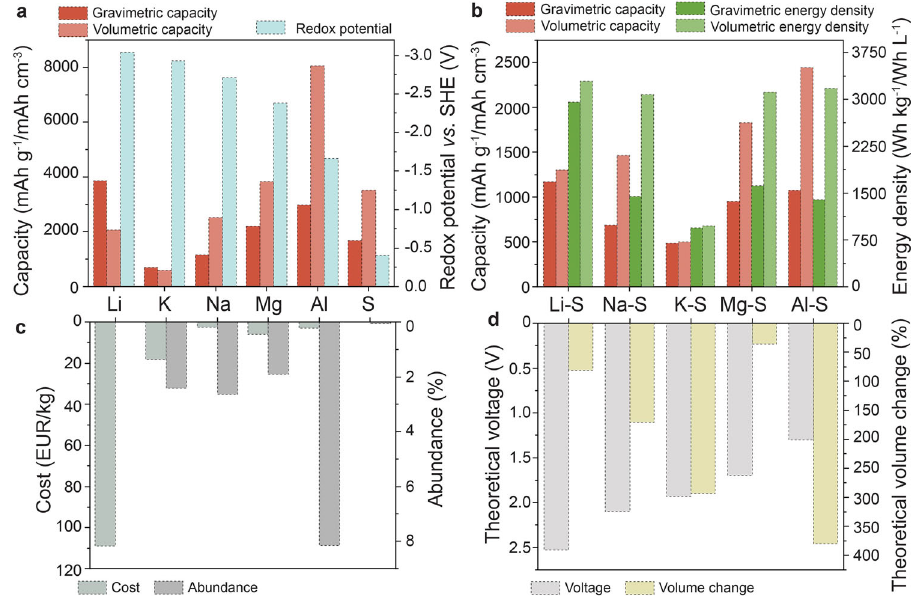
Fig. 1 Comparison of Li – S, Na – S, K – S, Mg – S and Al – S batteries and their components. a Redox potentials and gravimetric/volumetric capacities of Li, K, Na, Mg, Al and S; b Theoretical gravimetric/volumetric capacities and energy densities of Li – S, Na – S, K – S, Mg – S and Al – S batteries; c Abundance in Earth crust and cost of Li, K, Na, Mg, Al and S; d The theoretical voltage and theoretical volume changes upon cycling of Li – S, Na – S, K – S, Mg – S and Al – S batteries.